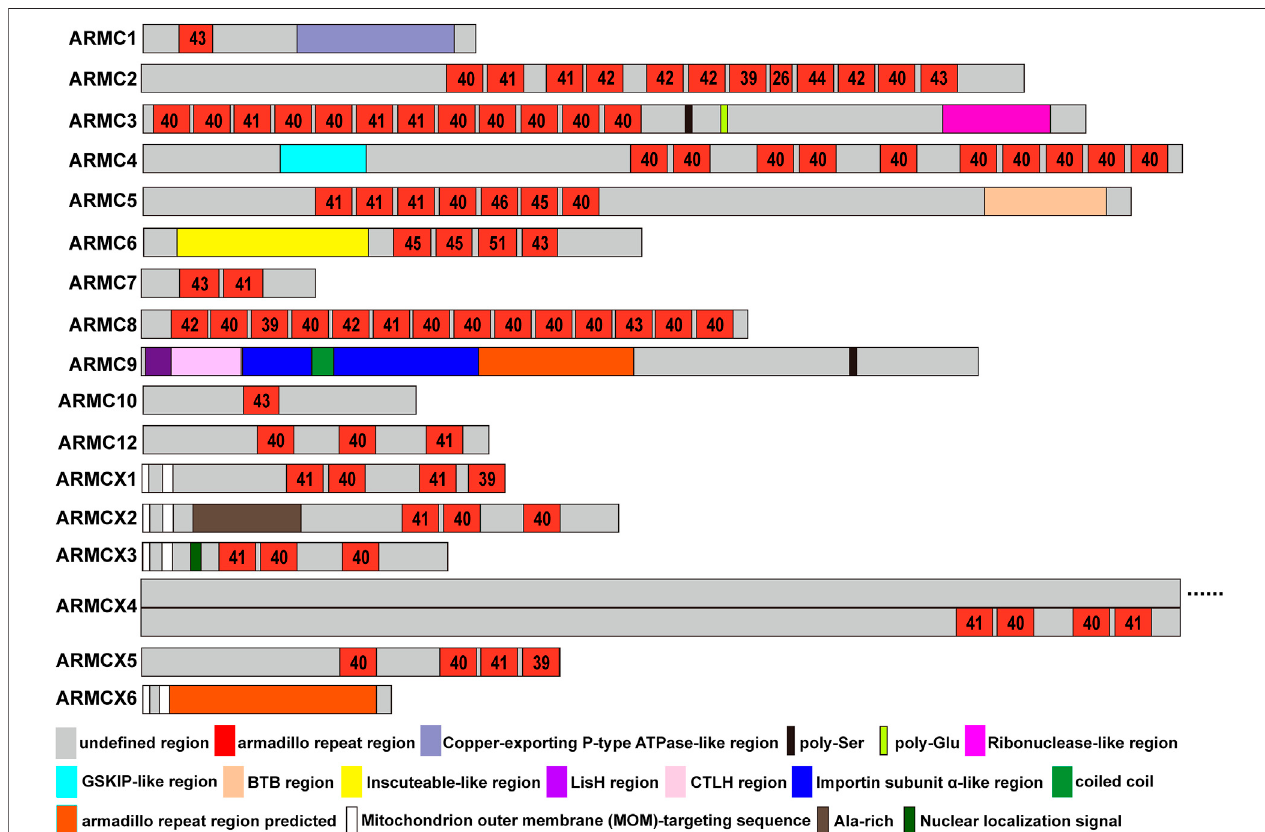
FIGURE 2 | ARMC subfamily. The length and location of each domain in the ARMC subfamily are roughly depicted. Shown are the unde fi ned region (gray), Armadillorepeat region (red), Copper-exporting P-type ATPase-likeregion (lightblue),poly-Ser (black),poly-Glu (limon), Ribonuclease-like region (magenta), GSKIP-like region(cyan),BTBregion(wheat),Inscuteable-likeregion(yellow),LisHregion(purple),CTLHregion(pink),Importinsubunit α -likeregion(blue),coiledcoilregion(green), predicted Armadillo repeat domain (orange), MOM-targeting sequence (white), Ala-rich region (sand), and nuclear localization signal (forest). The numbers in the checks represent the number of amino acids in the armadillo repeat